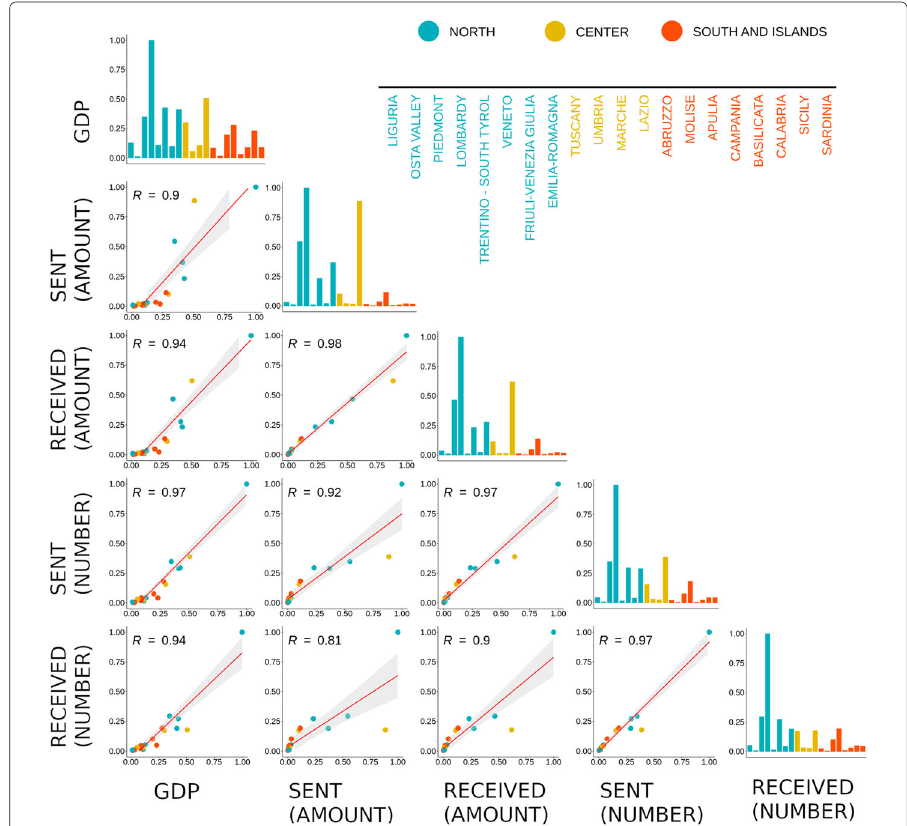
Fig. 3 Correlation scatter plots matrix: Mutual correlations between regional GDP, incoming/outgoing wire transfers number, and incoming/outgoing wire transfers total amount, all grouped by regions, are very high. Wire transfers number correlates better with GDP, also because wire transfers total amount exhibits some peculiar outliers (such as Lazio) that behave differently along the distributions. Notice that all the p-values are much lower than 10 − 4 . On the diagonal the plots for GDP, sent/received transfers (number and amount) reveal big inequalities between regions. Values have been normalised according to the maximum value (Lombardy) while on the x-axis regions follow the order shown in the legend. Please observe that due to the bank’s policy, we cannot show the actual values of wire transfers numbers and amounts, but only their